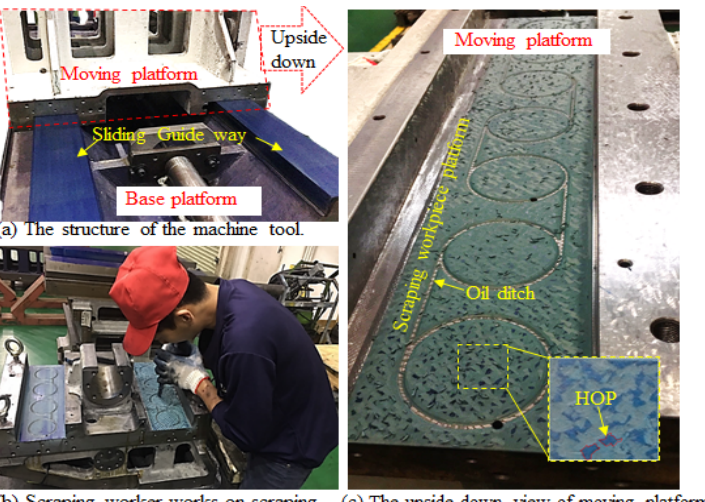
Figure 1. The introduction to scraping workpieces.